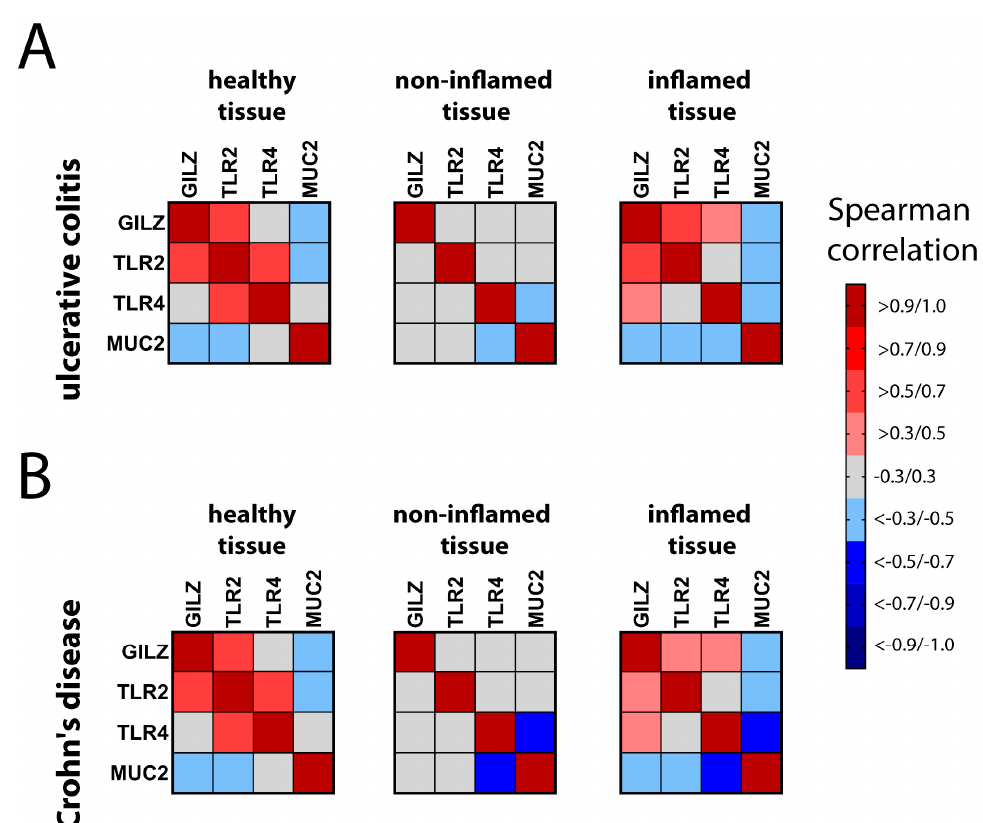
Figure 4. Heat map showing pairwise comparisons of GILZ , MUC2 , TLR2 , and TLR4 expression. Pairwise comparisons of the genes were made using Spearman’s correlation analysis for healthy control tissue (in ( A , B )) and inflamed/non-inflamed UC ( A ) and CD ( B ) tissues. Positive correlations are presented in the upper red part of the scale, while negative correlations are presented in the lower blue part of the scale. Correlation values between 0.3 and − 0.3 were not considered significant and are shown in grey.